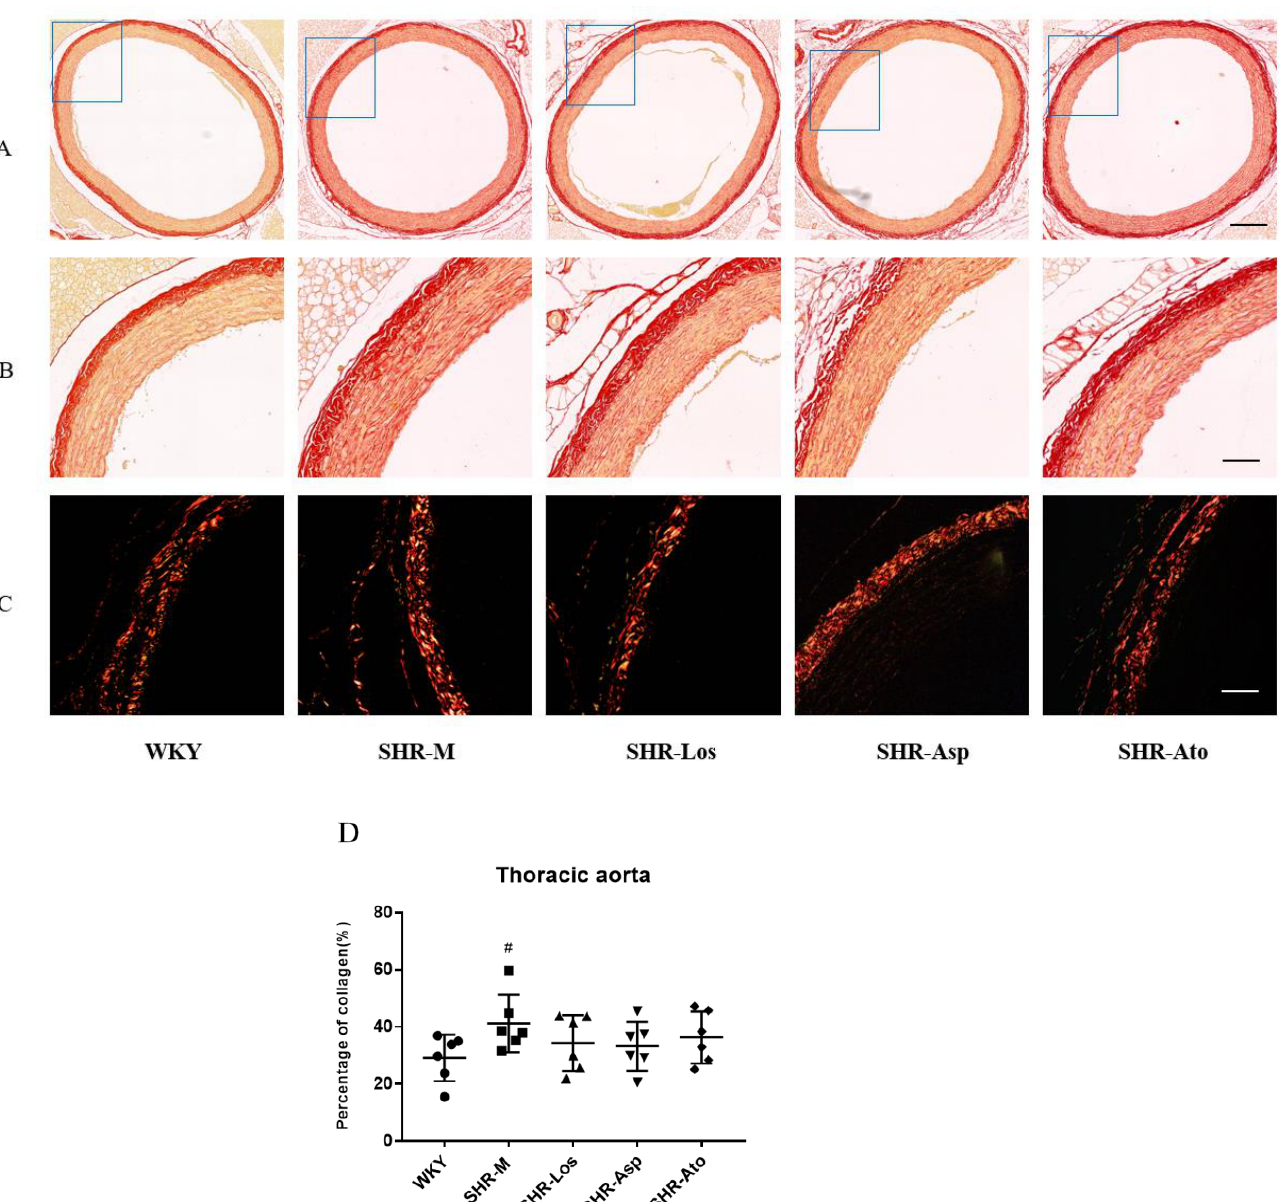
Figure 4. The distribution of collagen fibers in cross sections of thoracic aortas (22 weeks rats). ( A ) Sirius Red stain of collagen fibers under optical microscope (scale bar = 300 µ m); ( B ) magnified images of ( A ) (scale bar = 100 µ m); ( C ) Sirius Red stain of collagen I and collagen III under polarized light microscopy, collagen I was bright red or strong orange–red, and collagen III was green (scale bar = 100 µ m); ( D ) the percentage of collagen fibers in thoracic aortas. The data are presented as the mean ± SD. n = 6, # p < 0.05, vs.